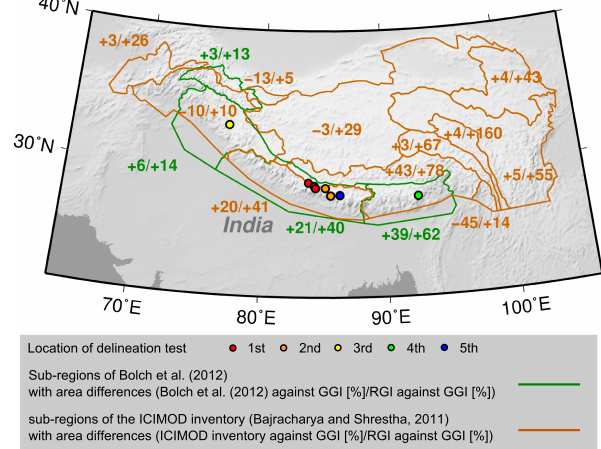
Figure 17. Overview of area comparisons and catchment outlines for each sub-region.